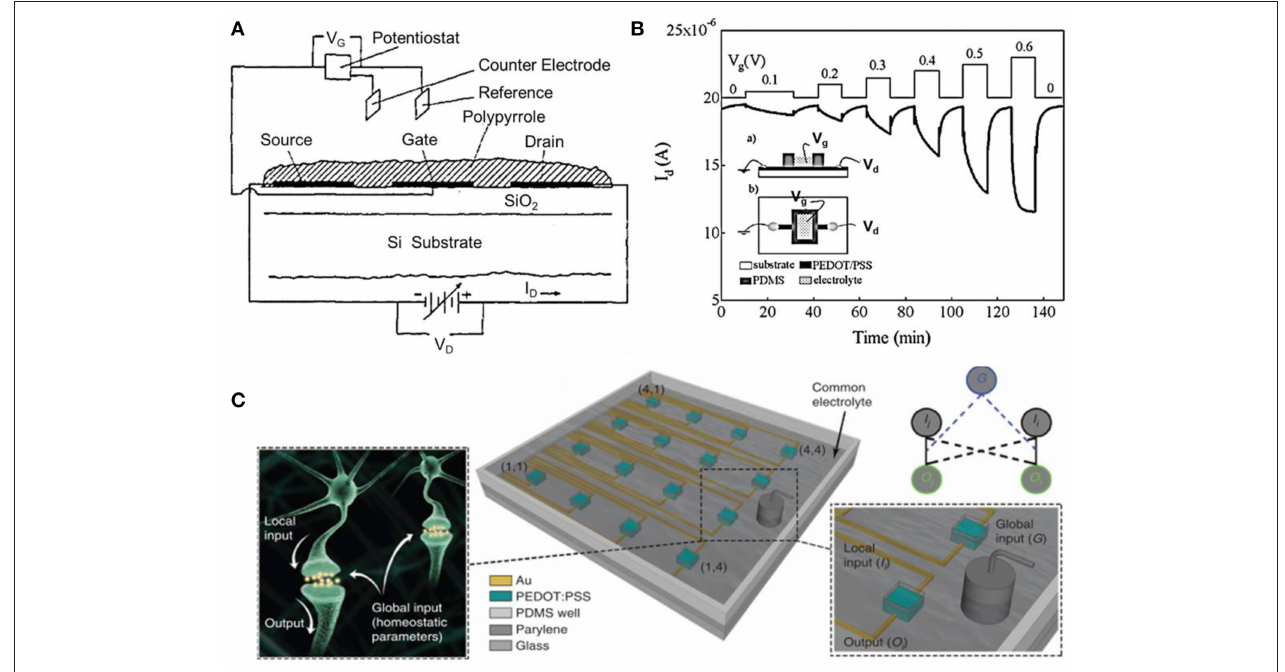
FIGURE 2 | (A) Cross-section view of the array of three gold microelectrodes with polypyrrole fabricated transistor (White et al., 1984). Reproduced with permission (White et al., 1984). Copyright © 1984 American Chemical Society. (B) Drain current-time response of PEDOT: PSS device. (Inset: the side view (a), and is top view (b) of the device) ( Zhu et al., 2004). Reproduced with permission (Zhu et al., 2004). Copyright © 2004 The Royal Society of Chemistry. (C) Illustration of PEDOT: PSS array, neurons are immersed in the same electrolyte and the analogy diagram of the device grid ( Gkoupidenis et al., 2017). Reproduced with permission (Gkoupidenis et al., 2017). Copyright © 2017 Nature Publishing